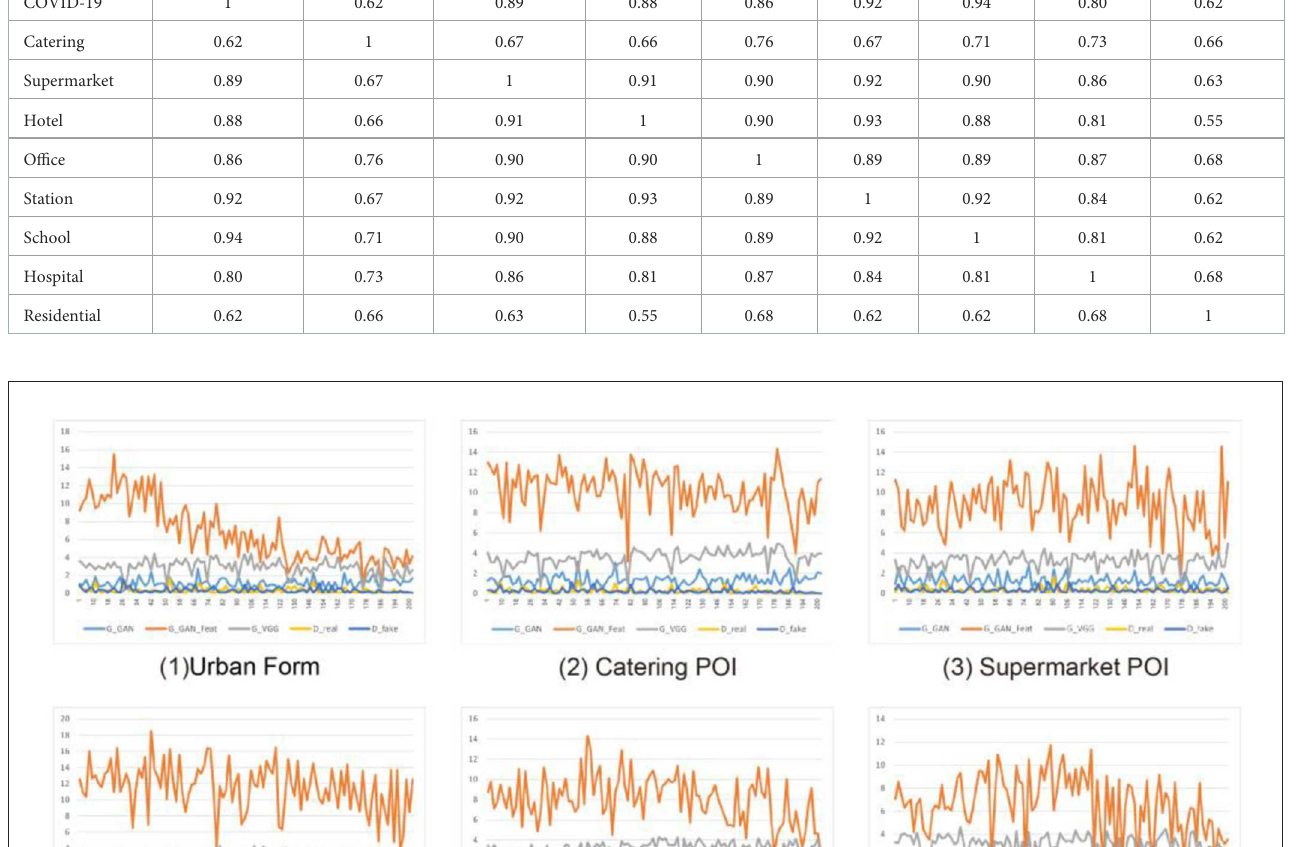
FIGURE6 Iterative training LOSS numerical statistics.